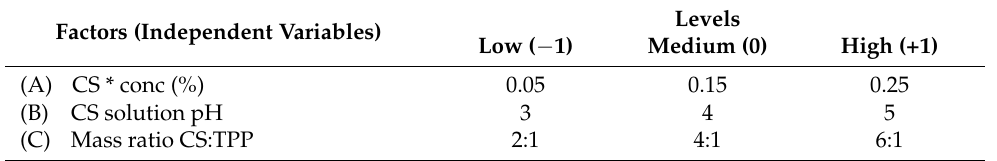
Table 1. Independant responses with their respective